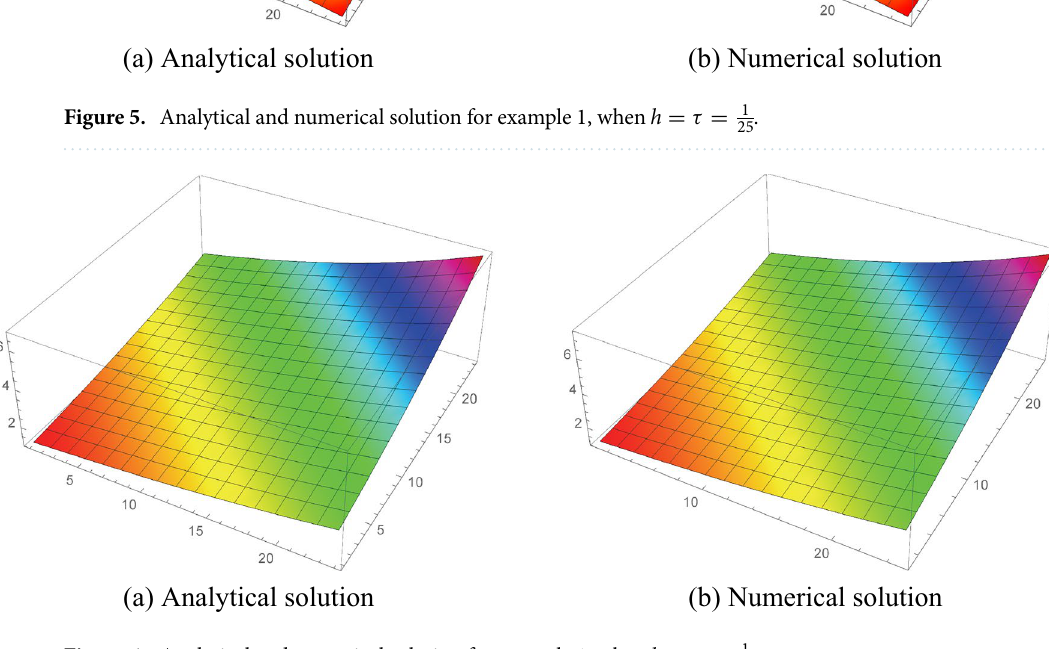
Figure 6. Analytical and numerical solution for example 1, when h = τ = 1 25